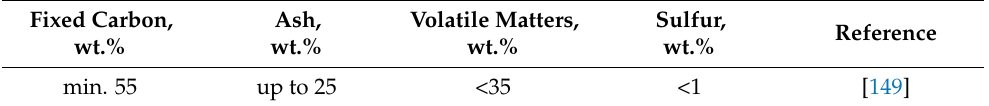
Table 8. Main requirements for fuel for FINEX. Fixed